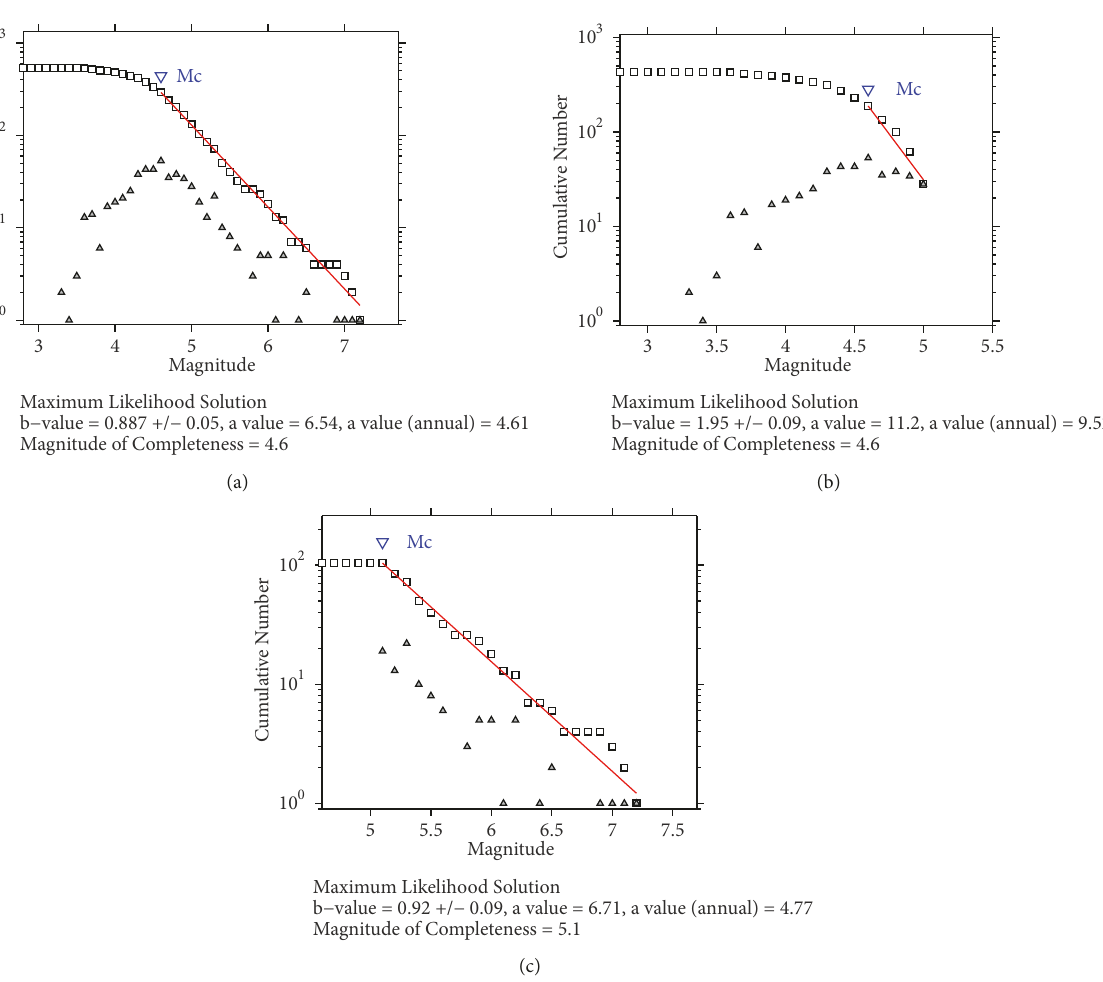
Figure 9: Magnitude distribution graph of seismicity for cluster 1 (Flores, Labuan Bajo, and surrounding areas): (a) for mb > 3 SR, (b) for mb= 3-5 SR, and (c) for mb > 5